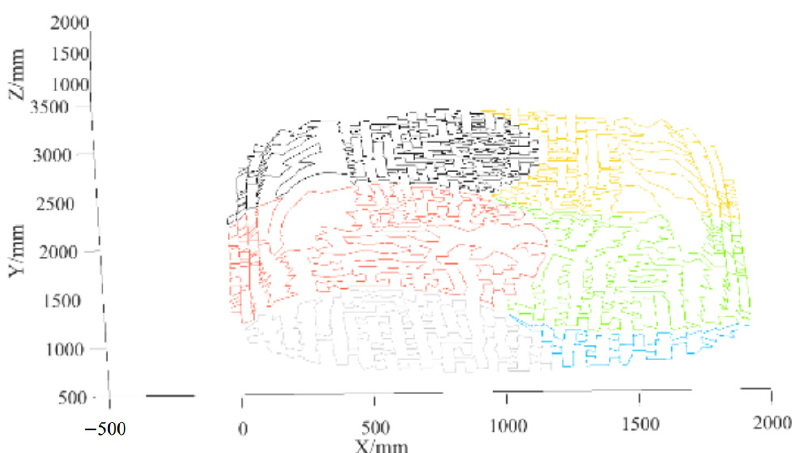
Figure 32. The final painting trajectory.